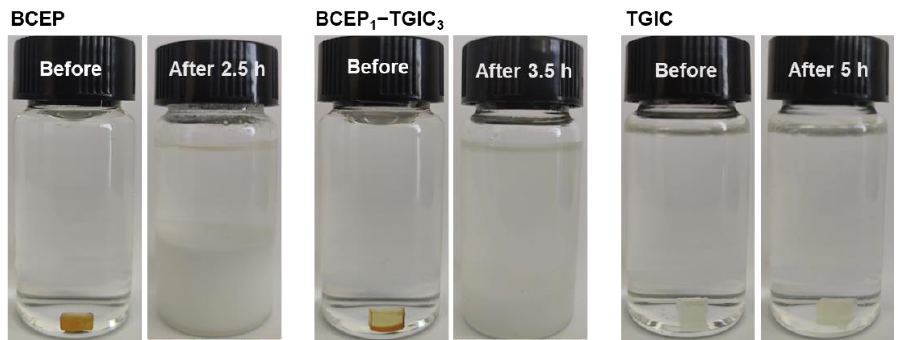
Figure 6. Photographs of the cured BCEP, BCEP 1 – TGIC 3 , and TGIC before and after chemical degradation in a methanol/water solution of NaOH under 50 °C.